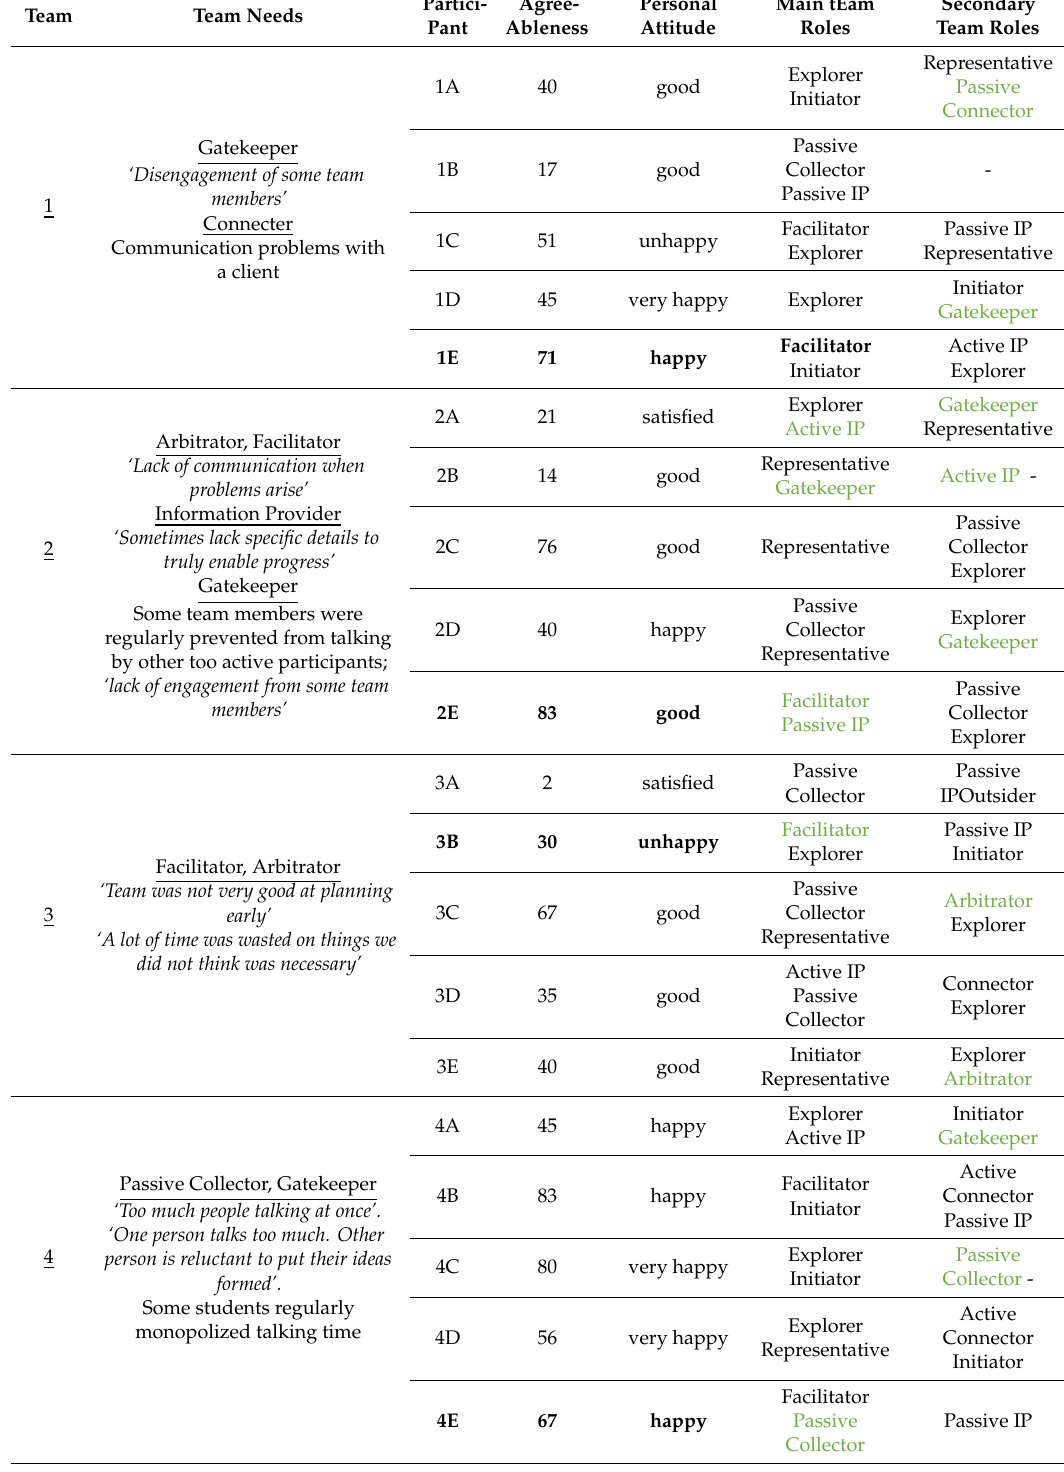
Table 4. Team role assignment in student teams